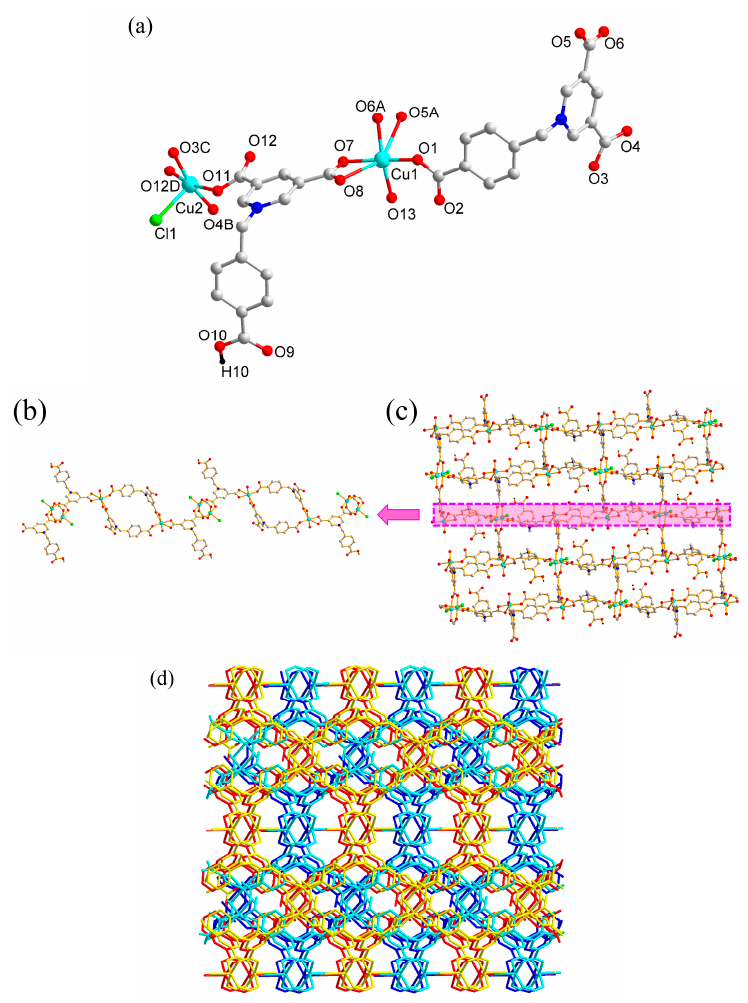
Figure 3. ( a ) Coordination environment of the metal atom and ligand of 3 (symmetry codes: (A) − x, − y, − z + 1; (B) − x, − y + 1, − z + 1; (C) x + 1, y + 1, z − 1; (D) − x + 1, − y + 2, − z; (E) x − 1, y − 1, z + 1). ( b ) The 1D infinite loop chain in compound 3 . ( d ) The 2D network of 3 . ( c ) The 3D supramolecular architecture of 3 . ( d ) Packing diagram in the space-filling model showing the 3D supramolecular architecture of 3 .